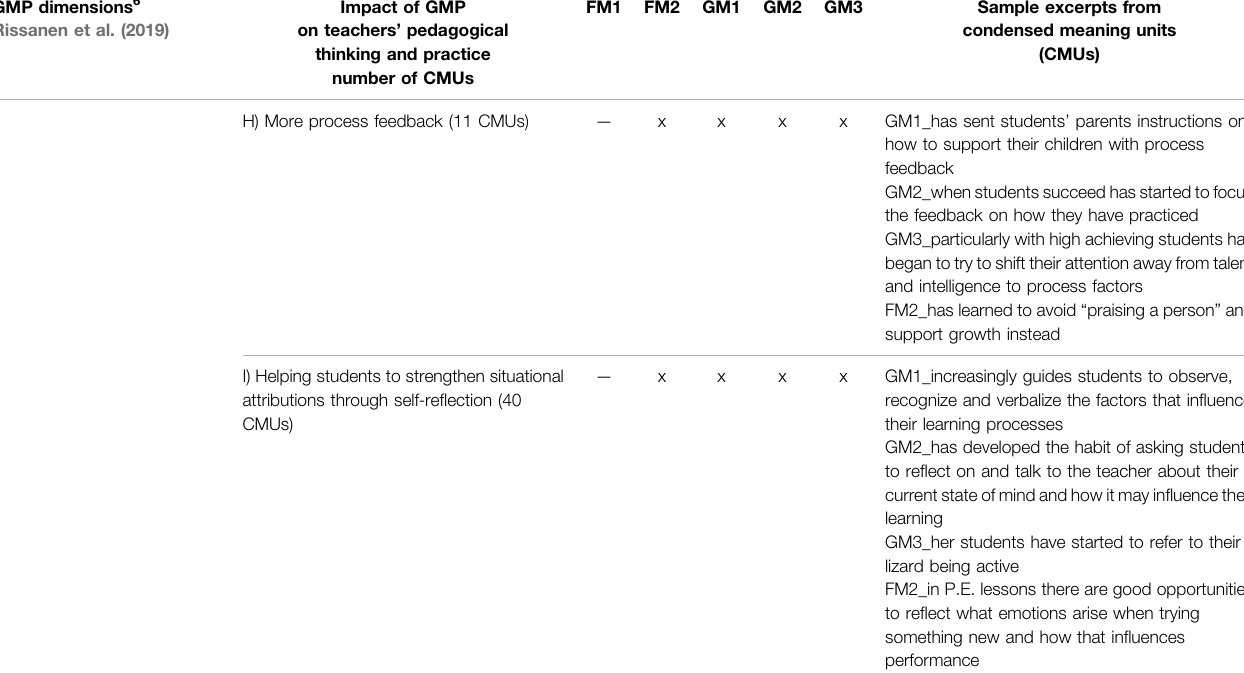
Sample excerpts from condensed meaning